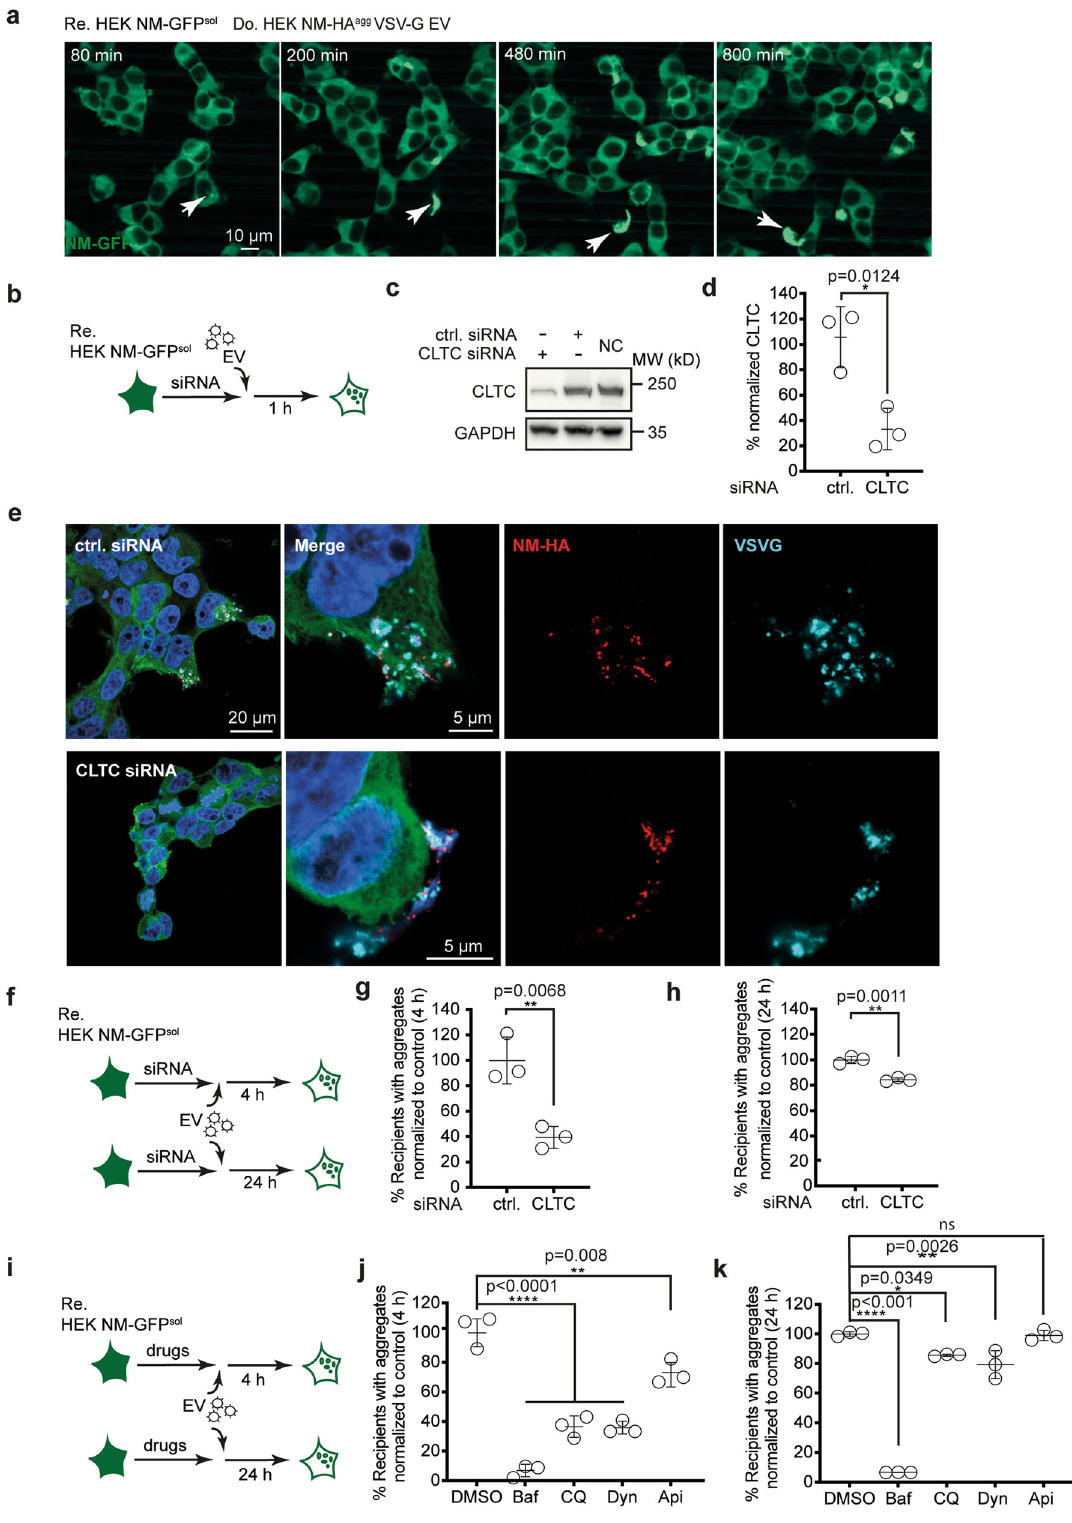
impaired aggregate induction (Fig. 3i – k). Raising the endosomal pH with Chloroquine, shown to partially inhibit VSV infection, had similar effects on aggregate induction by VSV-G- pseudotyped EV 45 . Aggregate induction was profoundly blocked in the presence of BafA1, an inhibitor of the H + -ATPase required for endosomal acidi fi cation, a process that triggers VSV-G mediated fusion and infection 46 . By contrast, Apilimod, a